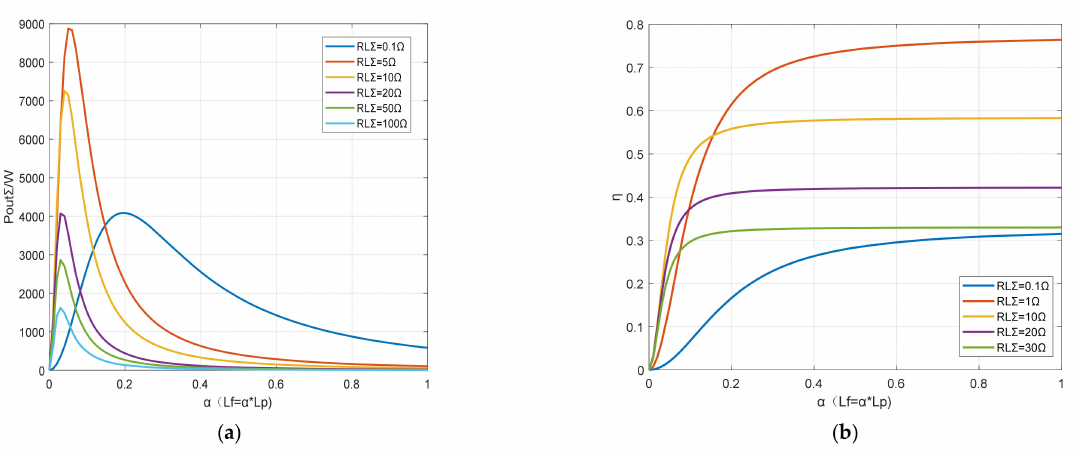
Figure 3. ( a ) The output power varies with α ; ( b ) the curve of transmission efficiency η changing with α .